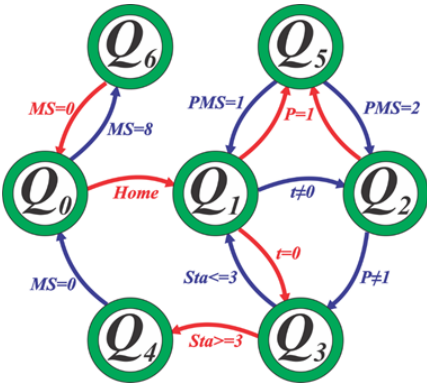
Figure 8. Diagram of the “M” state machine. Table 6. Description of the “M” State machine. State Description